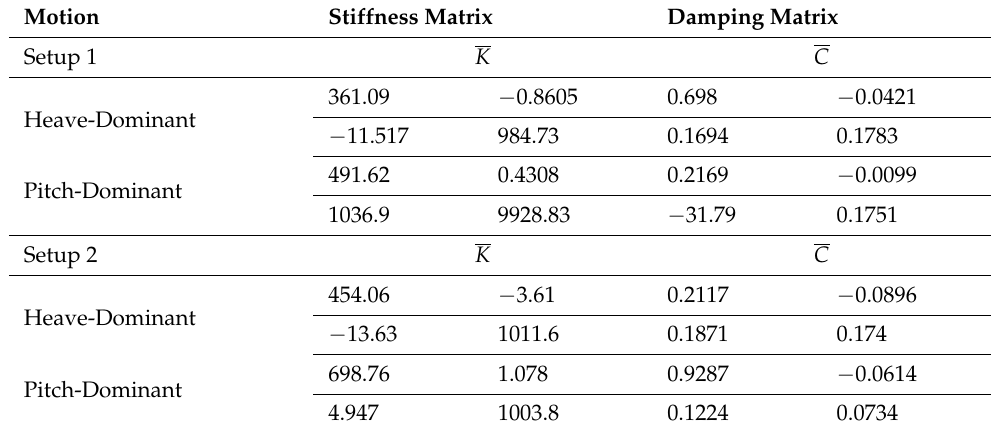
Table 4. Mechanical system matrices for wind-off conditions from the MITD method. Motion Stiffness Matrix Damping Matrix Setup 1 K C Heave-Dominant